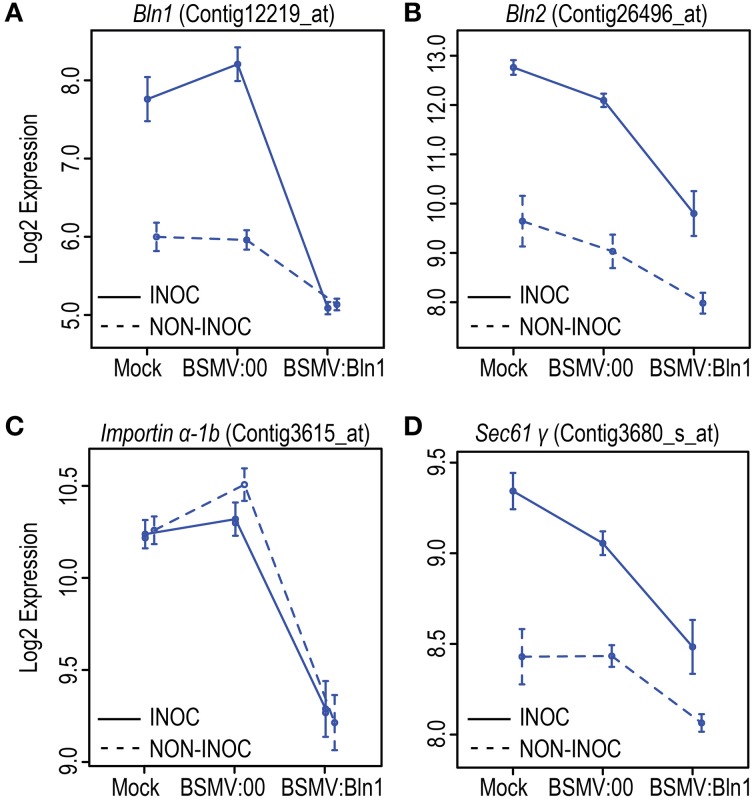
Log2 expression level results from Barley1 GeneChip profiling of
Bln1, Bln2, Importin
α-1b, and
Sec61
γ in
Bln1-silenced leaves. Barley stripe mosaic virus (BSMV)-Virus Induced Gene silencing was performed on HOR11358 (Mla9) plants as described in Figure 6. Twelve days after buffer and BSMV treatments, plants were inoculated with the compatible Bgh isolate 5874 (AVRa1, AVRa6, avra9, avra13). Log2 expression levels for Bln1
(A), Bln2
(B), Importin α-1b
(C), and Sec61 γ
(D) are plotted in graphs. INOC, inoculation; NON-INOC, Non-inoculated. Error bars represent the standard errors (SE).